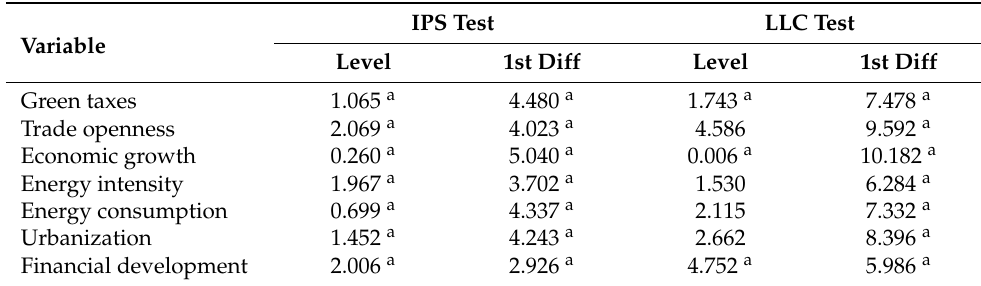
Table 4. IPS and LLC unit root tests.